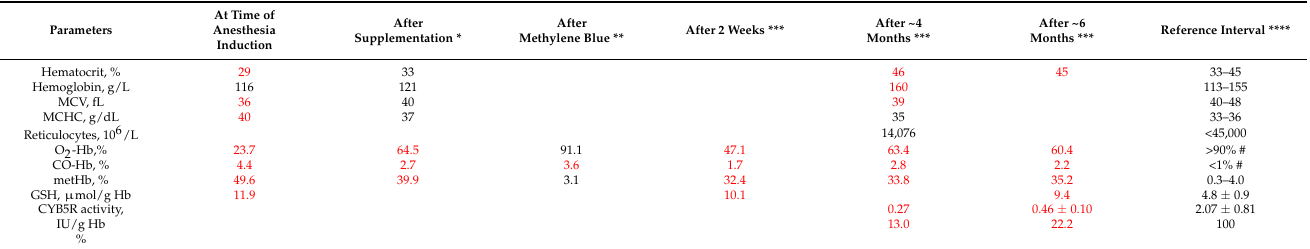
Table 1. Venous blood gases, erythrocytic metHb, reduced glutathione concentrations, and erythro- cytic CYB5R activity in a methemoglobinemic